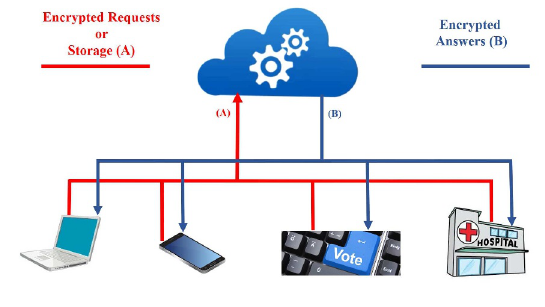
Figure 1: HE in a Cloud Based Scenario